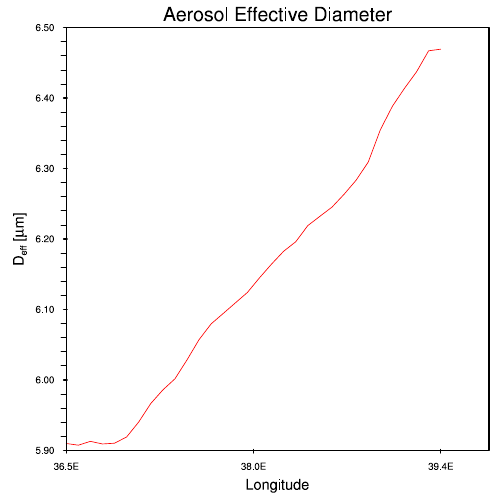
Fig. 13. Aerosol effective diameter [µm] in the lowest model layer along the cross section (ii) in Fig. 4 over the Red Sea averaged over the simulation period. The dust plume moves from East to West and the effective diameter decreases because of the predominant deposition of large